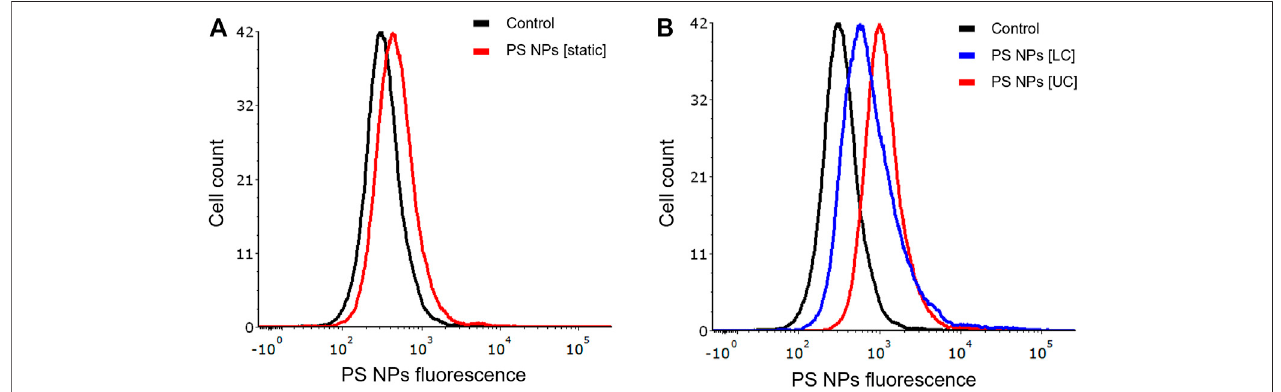
FIGURE 5 | Role of cell polarity. BEAS-2B cells showed differential uptake of PS NPs (10 μ g/ml) upon exposure through the upper and lower channels of the micro fl uidic device. (A) static conditions (conventional 24-well plate); (B) dynamic exposure using the COC platform. Cells were exposed for 1 h and the samples were analyzed by fl ow